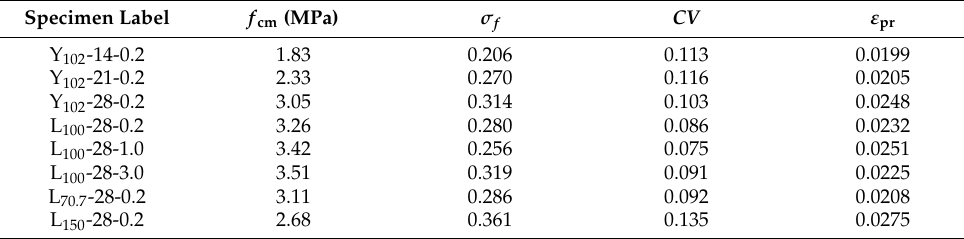
Table 5. Average compressive strength and peak compressive strain of earth specimen.